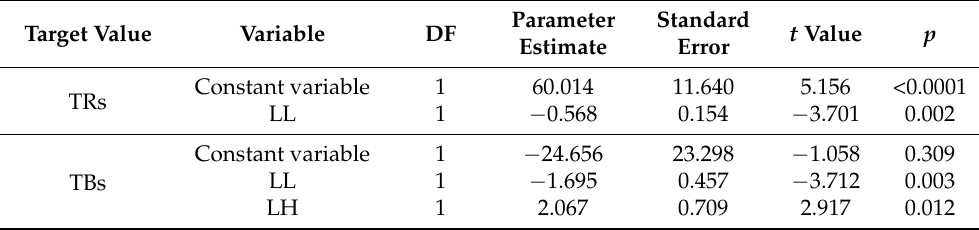
Table 2. Significances and parameter estimations of stepwise regression analysis using the TRs and TBs values as target